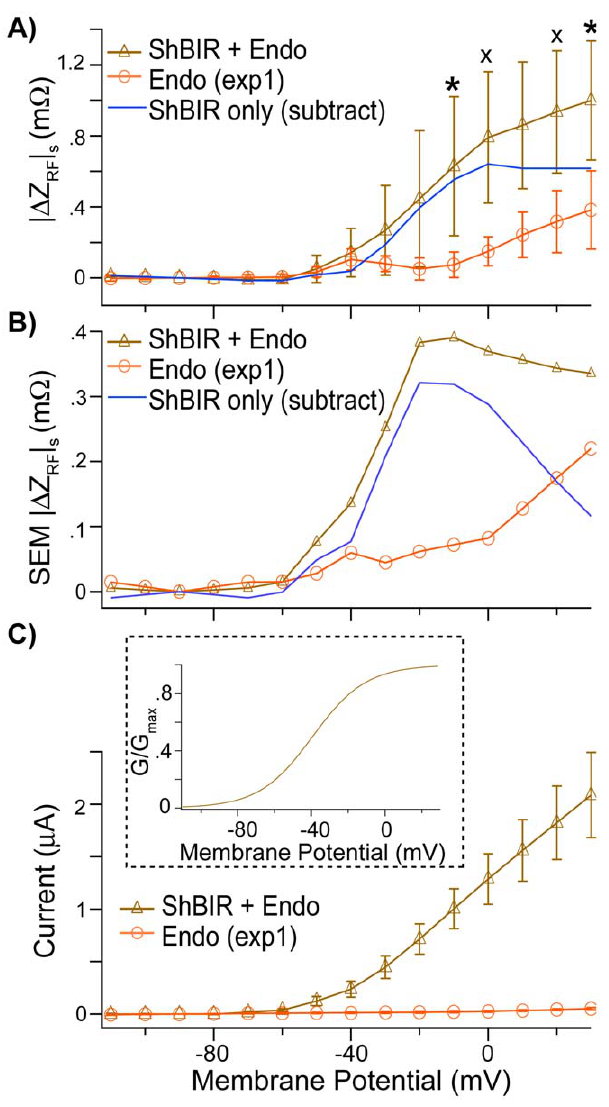
Figure 3. Steady-state RF response for Sh B-IR and Control Cells. A) Significant ( x p =.1, * p =.05) voltage-dependent differences in | D Z RF | s were observed between control oocytes, expressing endogenous proteins only (‘‘Endo’’, orange), and Sh B-IR expressing oocytes (express both endogenous and Sh B-IR proteins, ‘‘ Sh B-IR + Endo’’, brown). The ‘‘Endo’’ response was subtracted from the ‘‘ Sh B-IR + Endo’’ response to estimate the isolated RF response from the Sh B-IR channels only (‘‘ Sh B- IR only’’, blue). Error bars denote + / 2 standard errors of the mean (SEM). B) The SEM for the isolated Sh B-IR proteins (‘‘ Sh B-IR only’’, blue) was also estimated by subtracting the SEM from the control oocytes (‘‘Endo’’, orange) from the SEM associated with the Sh B-IR expressing oocytes (‘‘ Sh B-IR + Endo’’, brown). The SEM for isolated Sh B-IR expressing oocytes was largest near the half-activation potential for these ion channels. C) Sh B-IR channel expression and voltage- dependent whole-cell current was verified using TEVC, and this data was used to estimate Sh B-IR conductance (G/G max , inset).